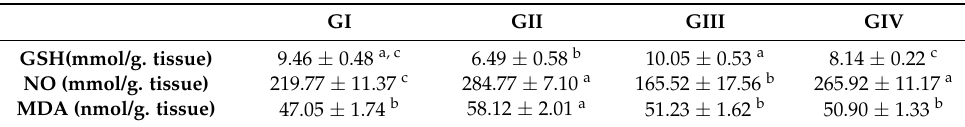
Effect of acrylamide and/or earthworm extract on testicular oxidative stress and antioxidant biomarkers.